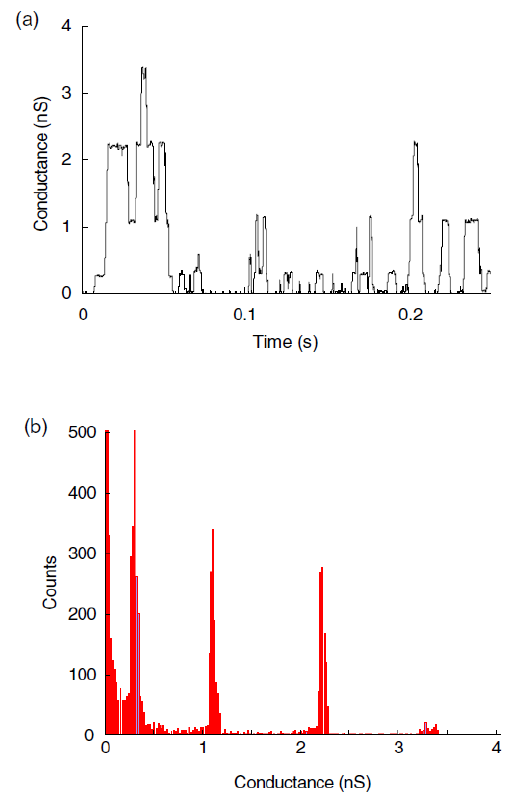
Figure 5. (a) Multiple levels of conductance of alamethicin pores at 70 mV. Channels of up to four conductance levels were observed: 0.3, 1.1, 2.2 and 3.34 nS. (b) Histogram of (a)